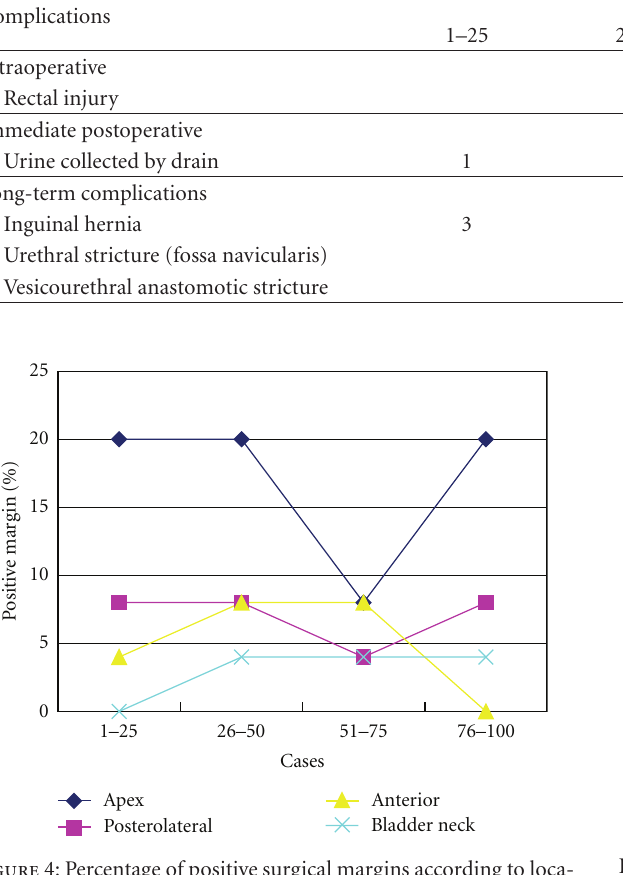
Figure 4: Percentage of positive surgical margins according to loca- tion and number of cases operated on consecutively. The technique of apical dissection was modified after Patient 33.